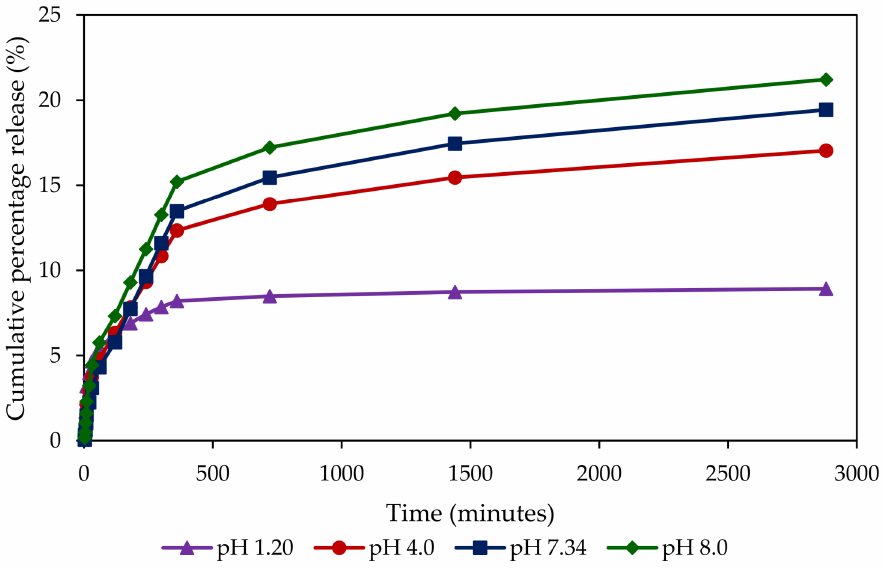
Figure 8. E ff ects of pH value on the release of MB from CMSP hydrogel